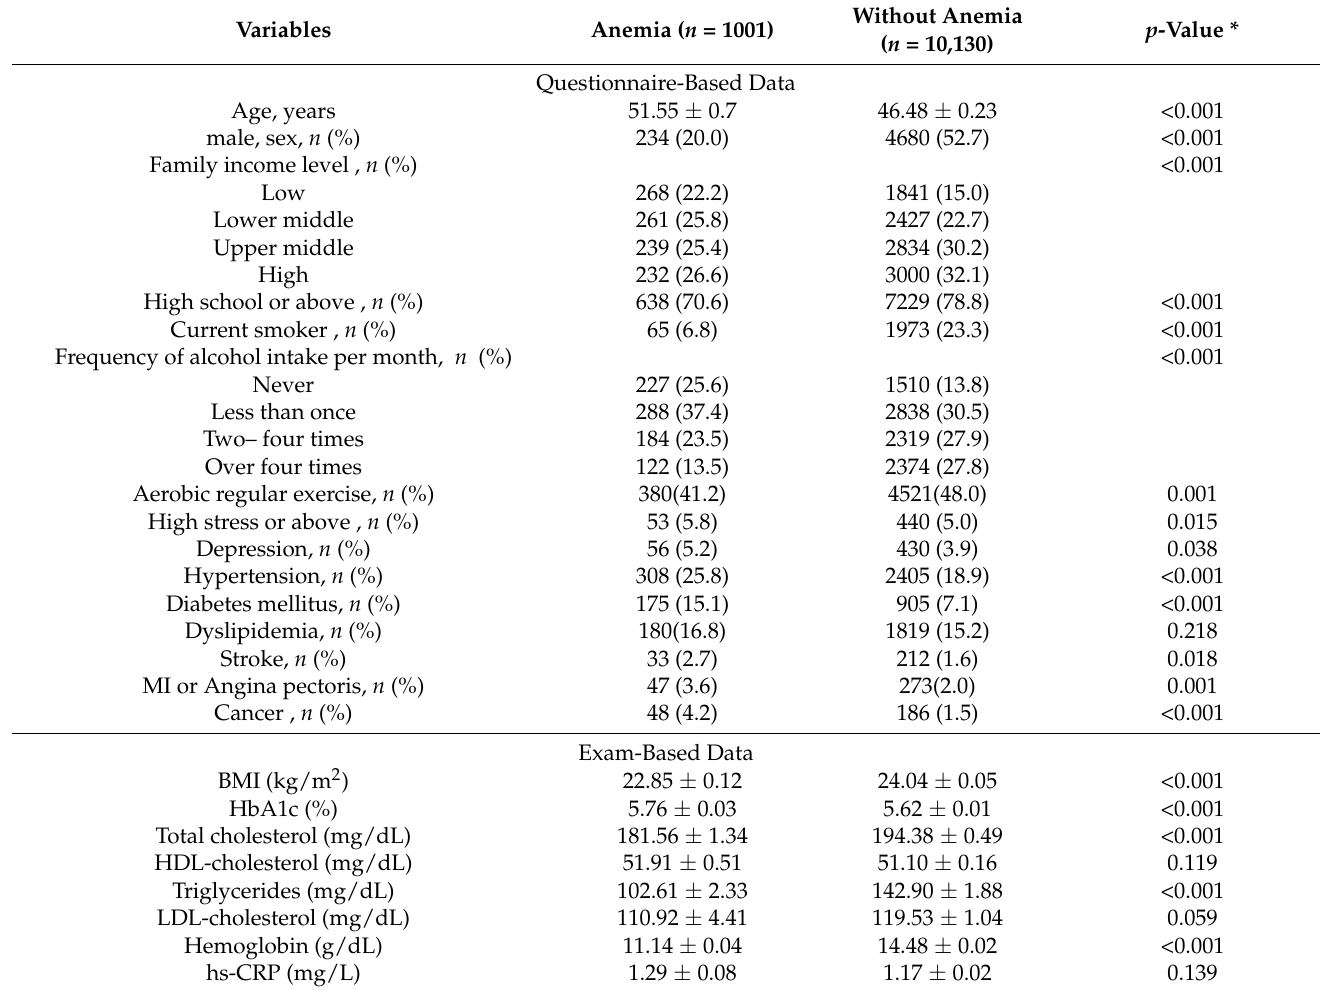
Table 2. Demographics of the study participants with anemia and without